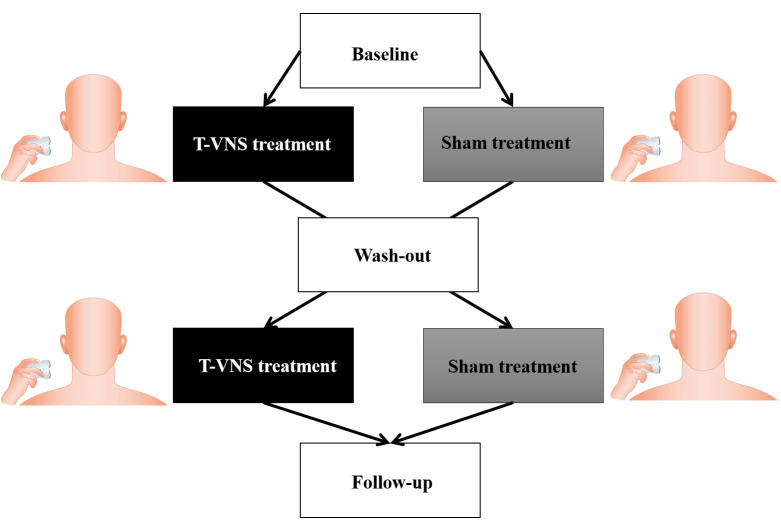
Study design & treatment procedure: Patients were instructed to self-administer the treatment bilaterally on the neck three times per day for two weeks at home.The treatment was delivered via two stainless steel contact surfaces that were covered with conductive gel before each treatment.